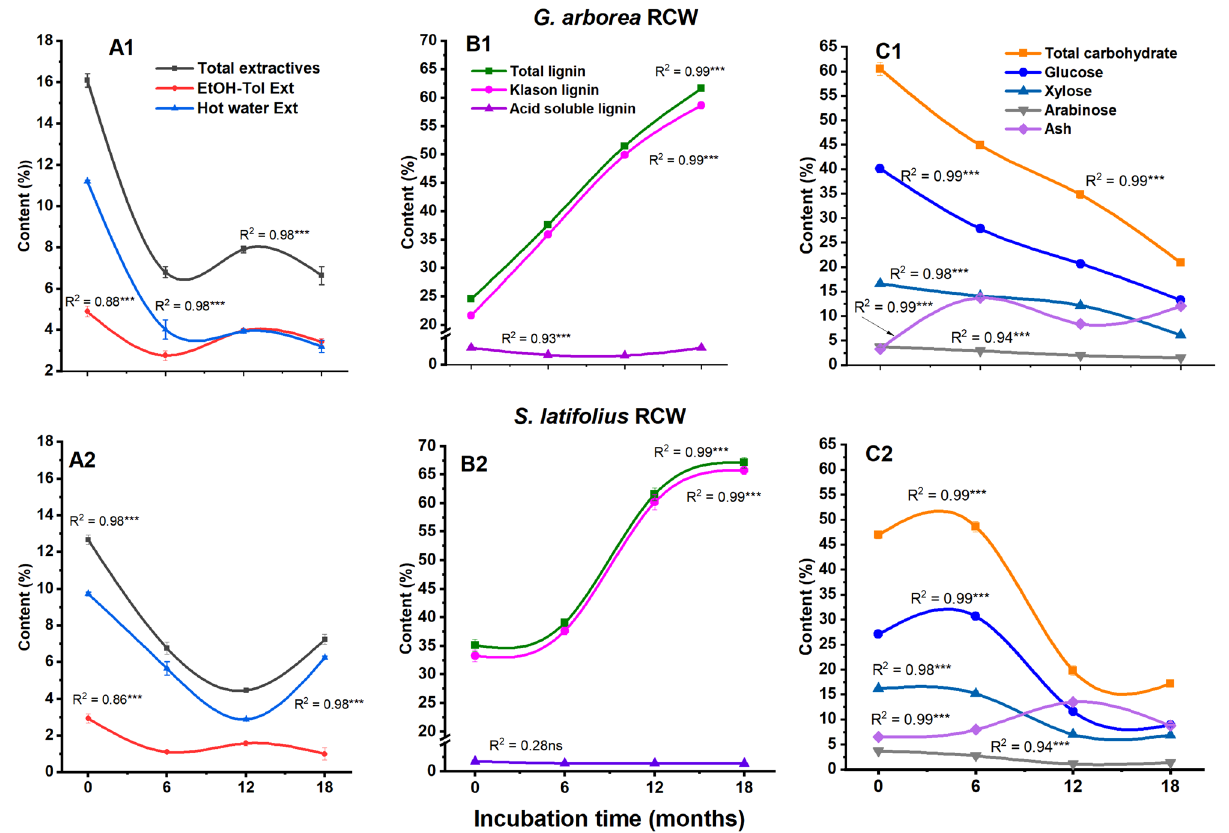
Figure 1. Content of chemical constituents of RCW of G. arborea ( A1 , B1 , C1 ) and S. latifolius ( A2 , B2 , C2 ) after 0, 6, 12 and 18 months of decomposition in soils. EtOH-Tol Ext, Ethanol-toluene extractives; RCW, ramial chipped wood, All contents are expressed as means ± standard errors (error bars) in triplicate. ***Contrasts significant at the 0.001 level, ns = not